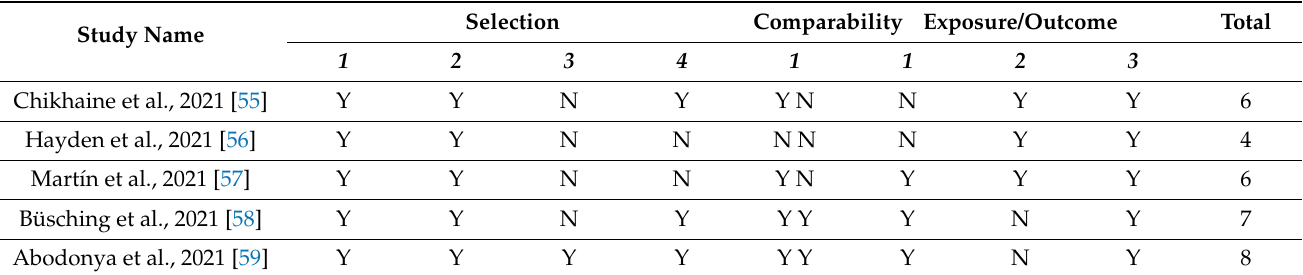
Table 3. Newcastle–Ottawa Scale for assessing quality appraisal.